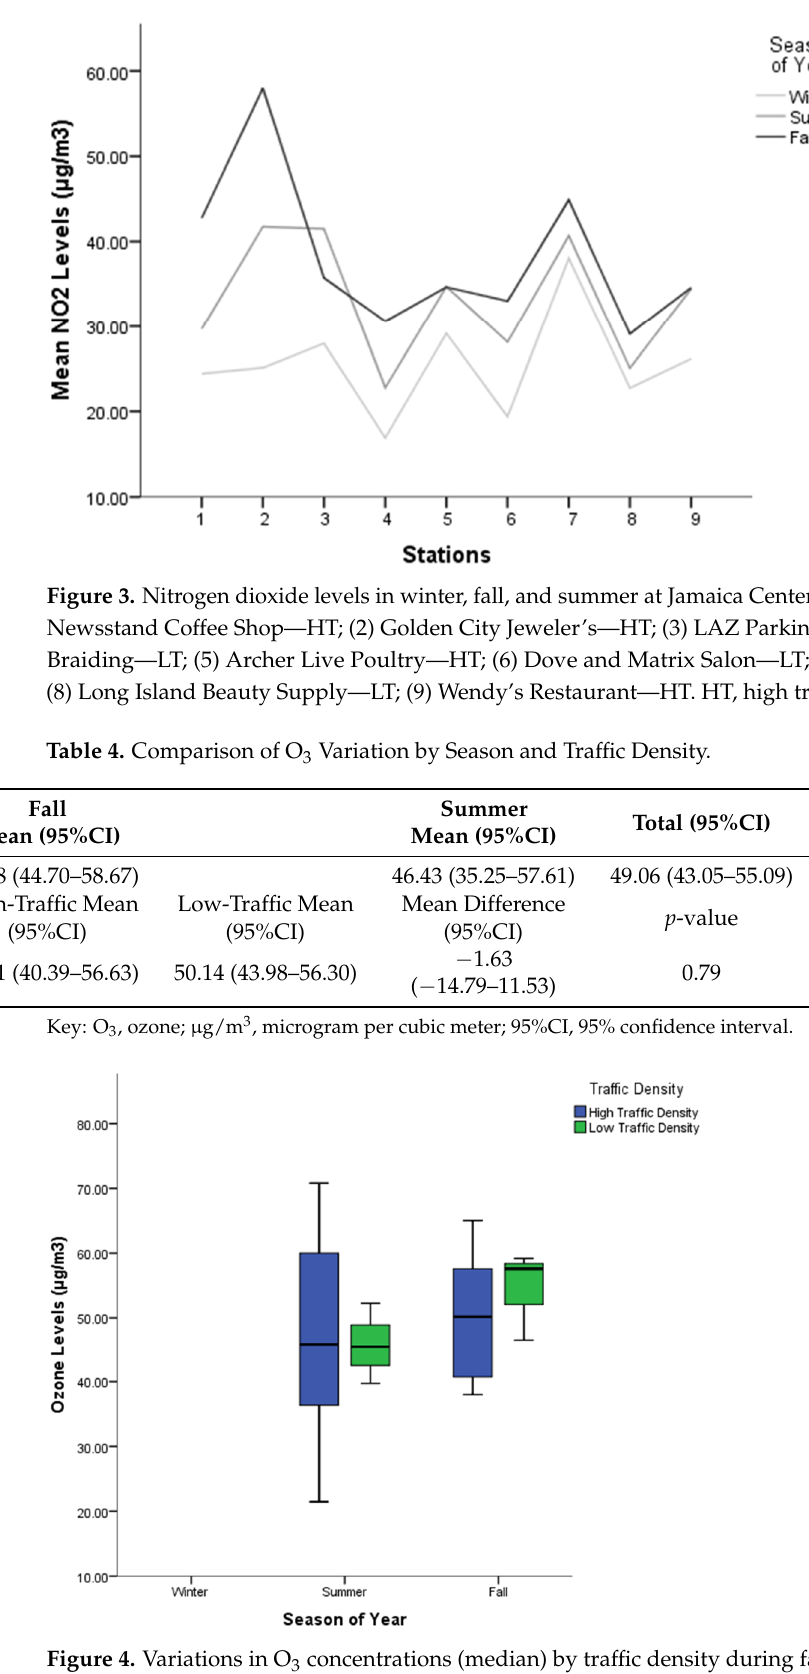
Figure 2. Variations in NO 2 concentrations (median) by traffic density across the three seasons.